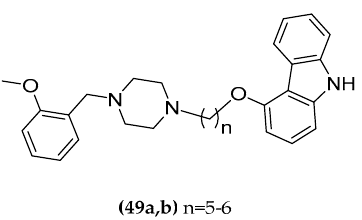
Figure 26. Dual-active AChE inhibitor/ nAChR agonist compounds.